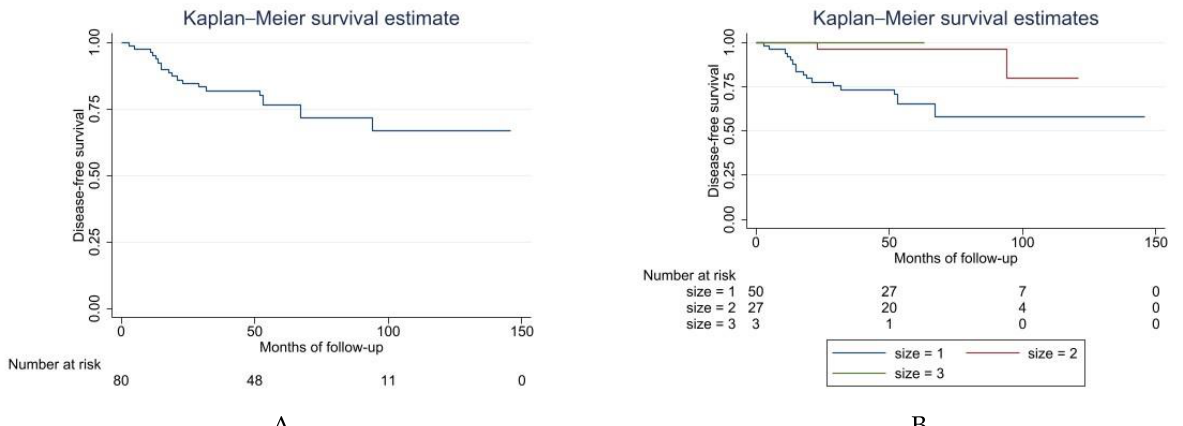
Figure 4. Disease-free survival Kaplan–Meier curve. ( A ) Overall DSF. ( B ) Kaplan–Meier curve comparing DFS by size of tumor: size 1 ≥ 10 cm, size 2 = 5–10 cm, size 3 ≤ 5 cm ( p =